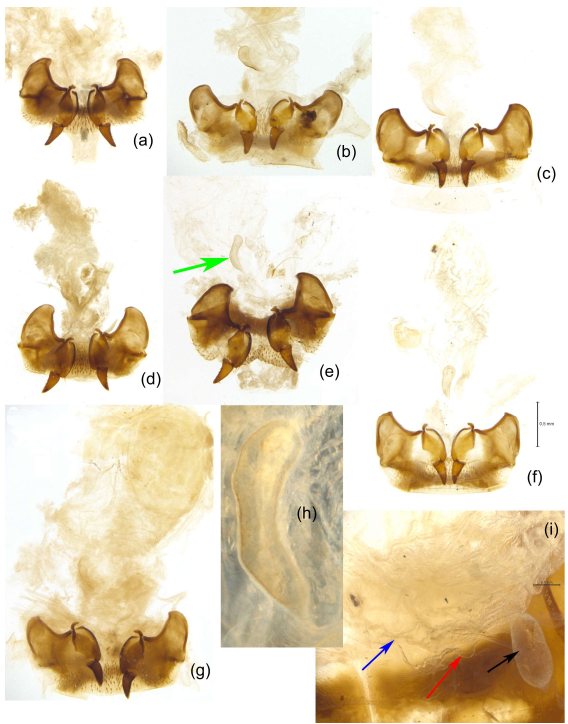
Figure 7. Female reproductive structures (ventral view): ( a ) P. depressus ; ( b ) P. vignai n. sp.; ( c ) P. complanatus ; ( d ) P. erythrocephalus ; ( e ) P. simonisi n. sp .; ( f ) P. peirolerii ; ( g ) P. maritimus n. sp .; P. complanatus ; ( h ) basal sclerite; and ( i ) spermathecal gland. Green arrow: natural position of basal sclerite. Black arrow: spermathecal gland. Red arrow: ductus of spermathecal gland. Blue arrow: insertion point of ductus. Scalebar= 0.5 mm ( a – g ) and 0.1 mm (i).